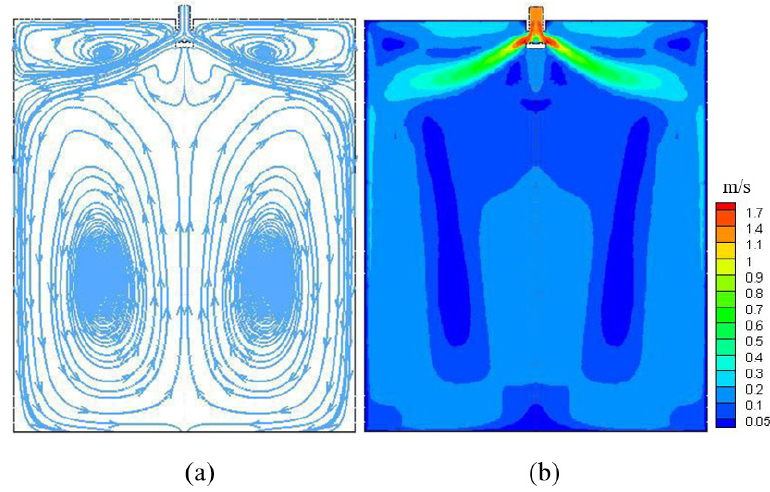
Figure 12. Fluid contours: ( a ) trajectory line; and ( b ) flow field at a 2300 mm width.